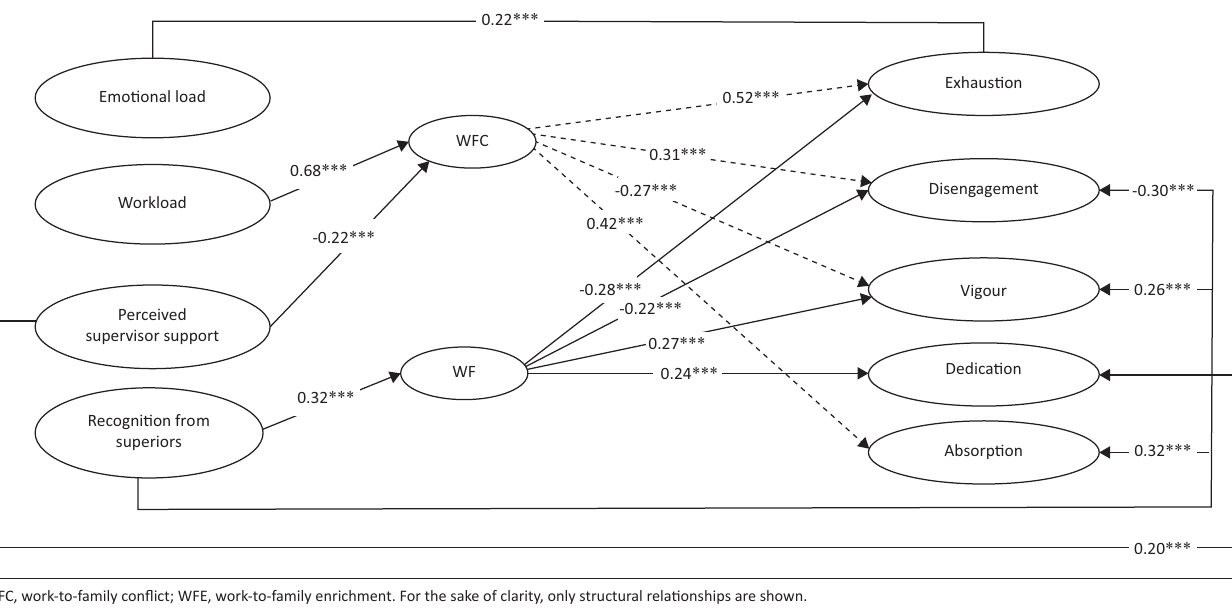
FIGURE 2: Completely standardised path coefficients for the retained model (Model 19).